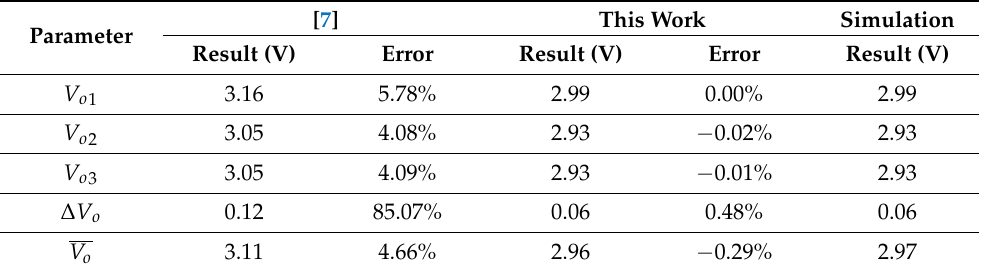
Table 2. The simulation result for dual-branch 1-stage linear charge